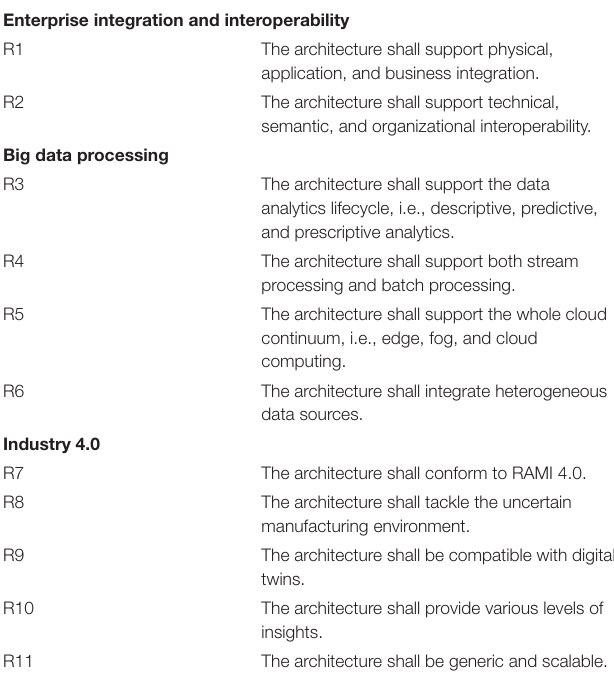
TABLE 1 | The requirements for the architectural